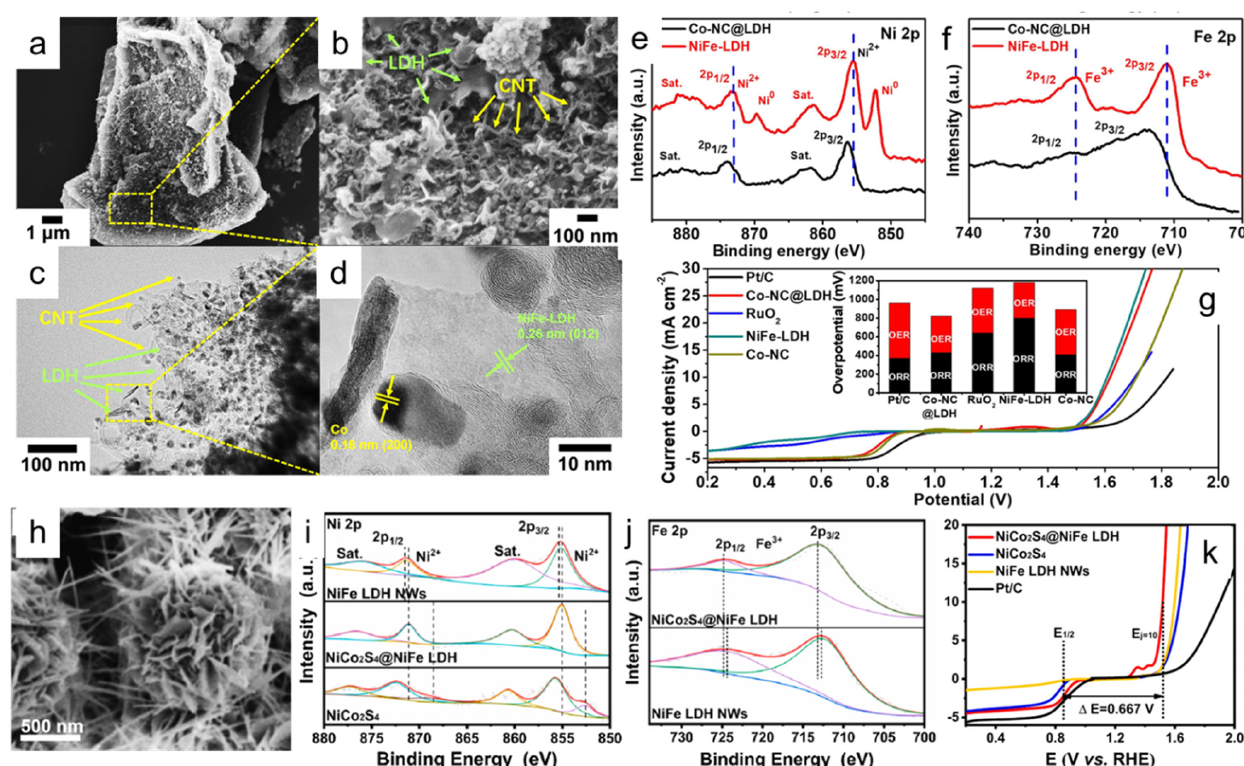
Figure 5. Structural characterization and electrochemical performance of Co − NC@LDH and NiCo 2 S 4 @NiFe LDH. ( a , b ) Co − NC@LDH at different magnifications; ( c , d ) TEM and HRTEM images of Co − NC@LDH. ( e , f ) Ni 2p and Fe 2p XPS spectra of NiFe ‐ LDH and Co ‐ NC@LDH. ( g ) LSV curves of Pt/C, Co − NC@LDH, RuO 2 , NiFe − LDH, and Co − NC for OER and ORR in O 2 − saturated 0.1 M KOH at 1600 rpm; inset shows potential differences between E 1/2 of ORR and E j=10 of OER for different catalysts. Reproduced from [95], copyright 2020, Elsevier. ( h ) SEM image of NiCo 2 S 4 @NiFe LDH. ( i ) XPS spectra of Ni 2p in NiCo 2 S 4 @NiFe LDH, NiCo 2 S 4 , and NiFe LDH nanowires. ( j ) XPS spectra of Fe 2p in NiCo 2 S 4 @NiFe LDH and NiFe LDH nanowire. ( k ) LSV curves of NiCo 2 S 4 @NiFe LDH, NiCo 2 S 4 , and NiFe LDH nanowires and Pt/C with a scan rate of 5 mV s − 1 at 1600 rpm. Reproduced from [98], copyright 2020, Elsevier.